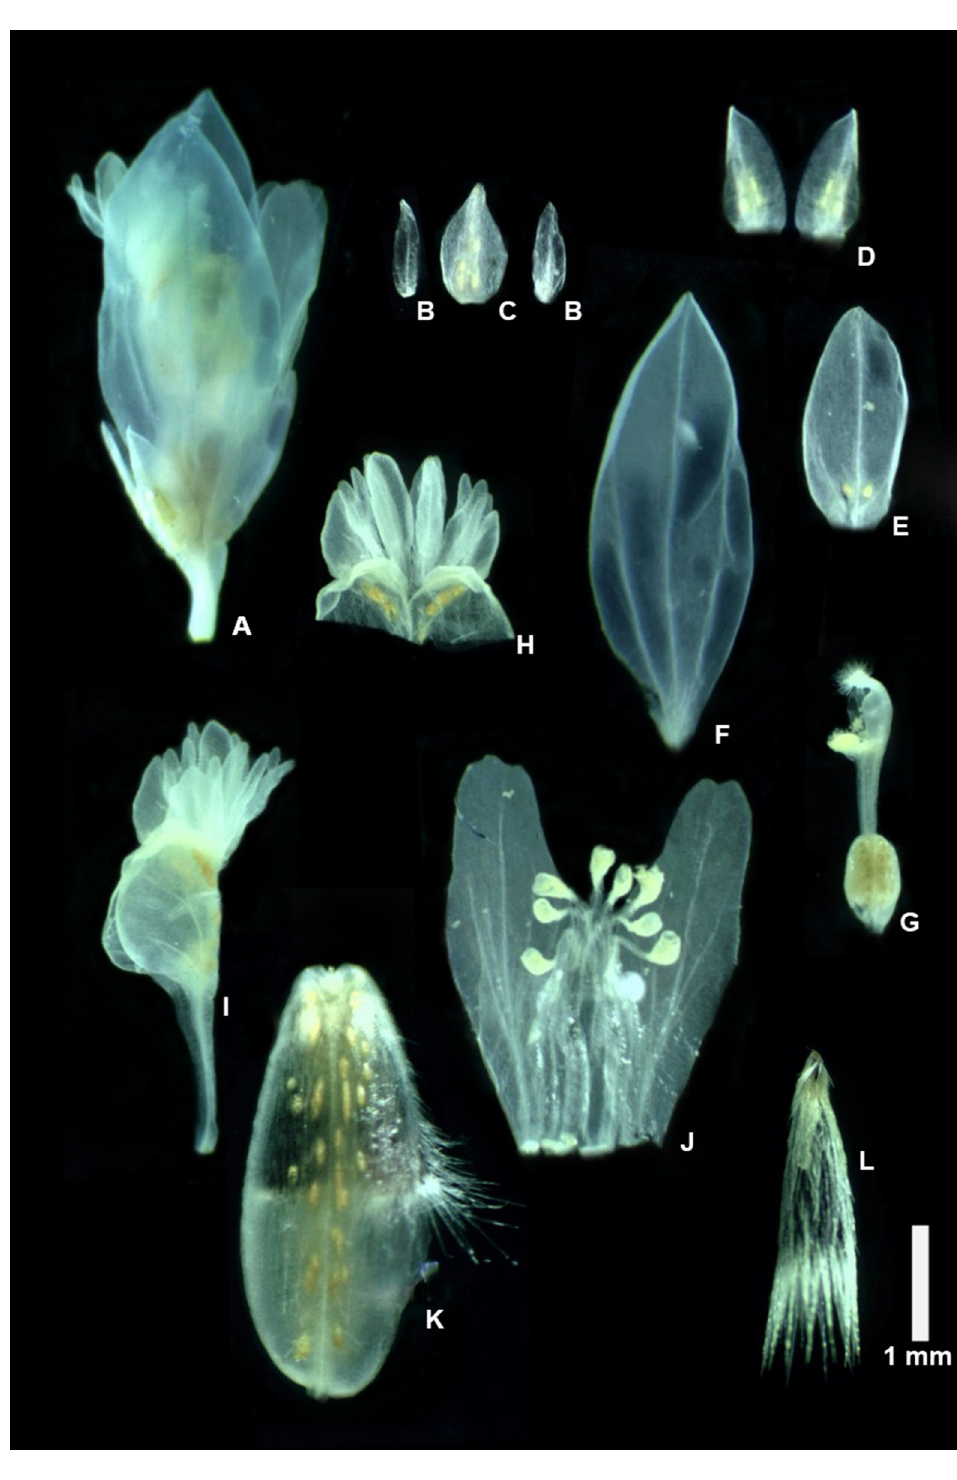
Fig. 7. Polygala trichosperma Jacq. A . Flower. B . Bracteoles. C . Bracts. D . Two upper outer sepals. E . Lower outer sepal. F . One of the two inner sepals (wings). G . Gynoecium. H . Crest. I . Keel. J . Androecium and lateral petals. K . Capsule. L . Seed. All from J.R. Abbott 19728. Photos: J.F.B.